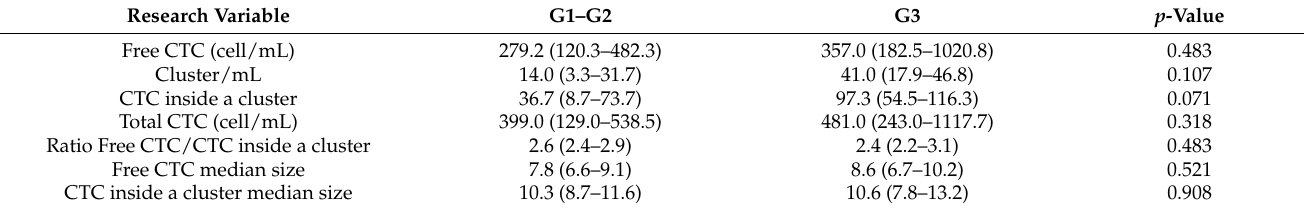
Table 2. Correlation CTC and clusters according to the degree of tumor differentiation (CVC measurements).